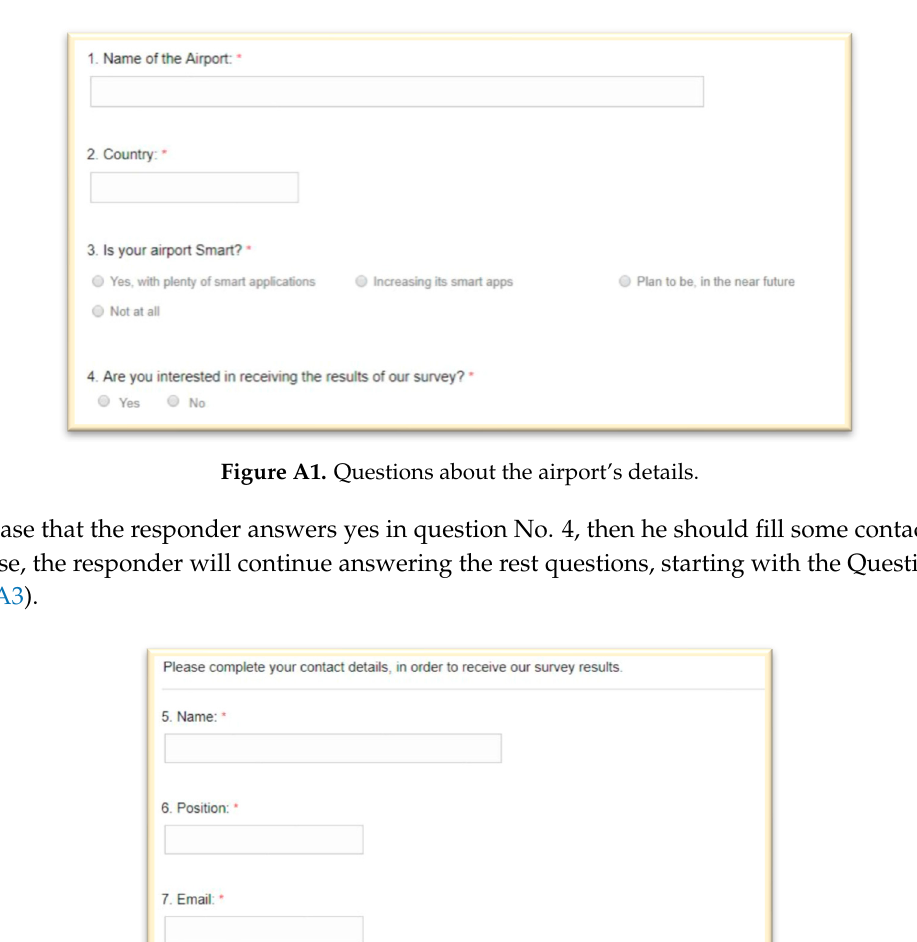
Figure A3. Question No 8. Figure A4. Question No 9. Figure A5. Question No 10 Figure A6. Question No 11.